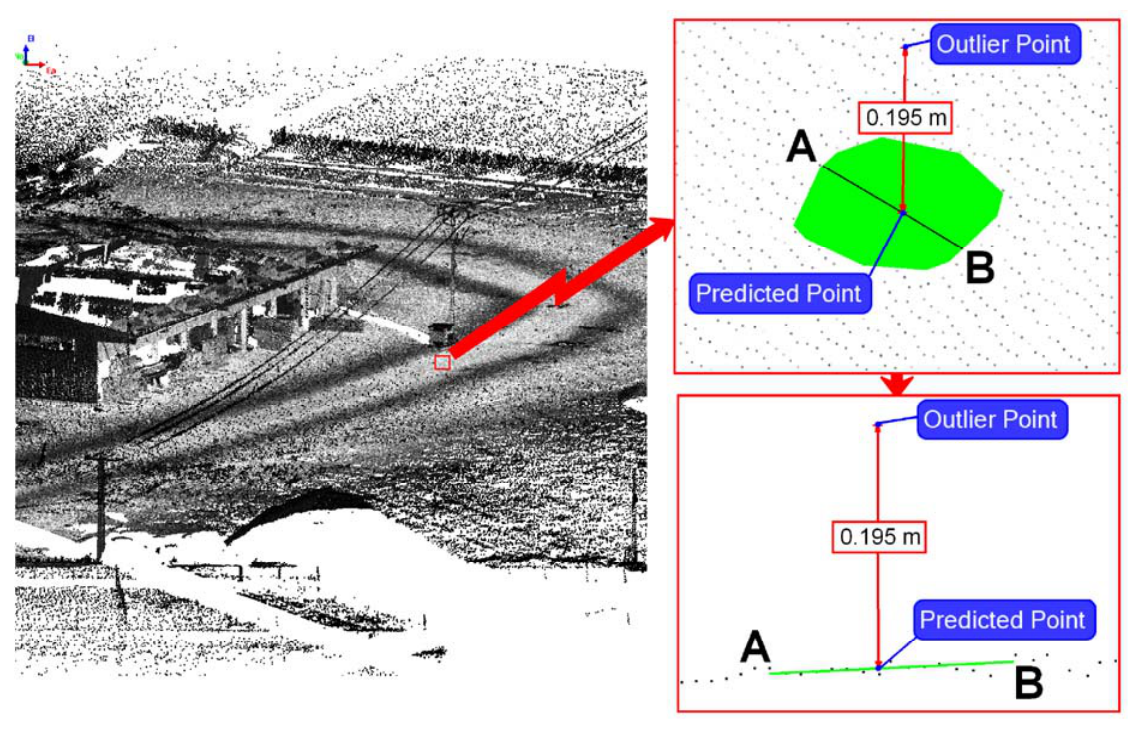
Figure 9. Section of a mobile terrestrial LiDAR point cloud collected with the Lynx Mobile Mapper. Object is being viewed from the